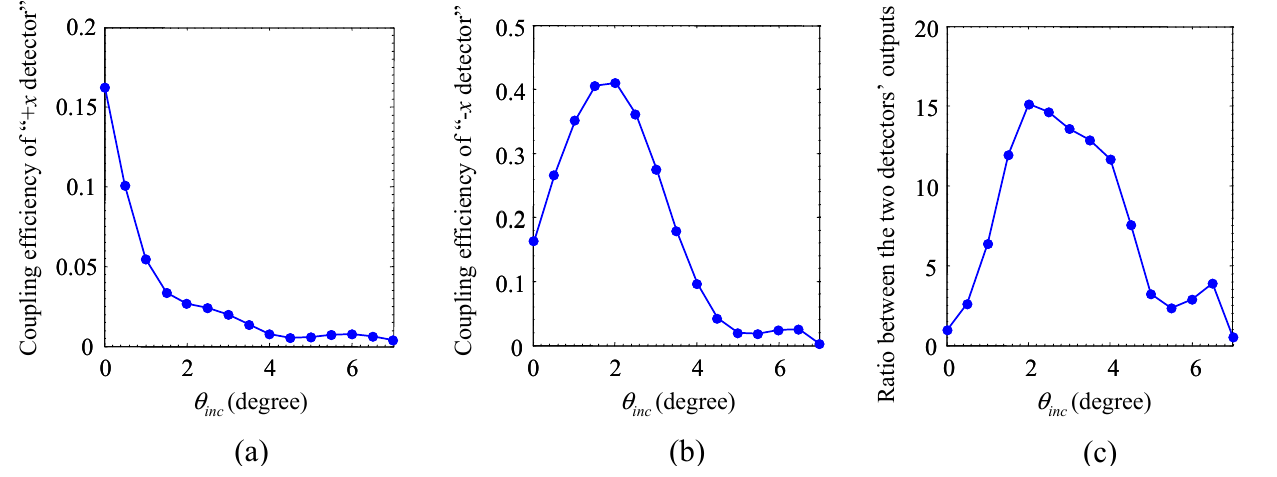
Figure 3. Numerical results for the angle detector. ( a ) Coupling efficiency of the “+ x detector.” ( b ) Coupling efficiency of the “ − x detector.” ( c ) Ratio between the two detectors’